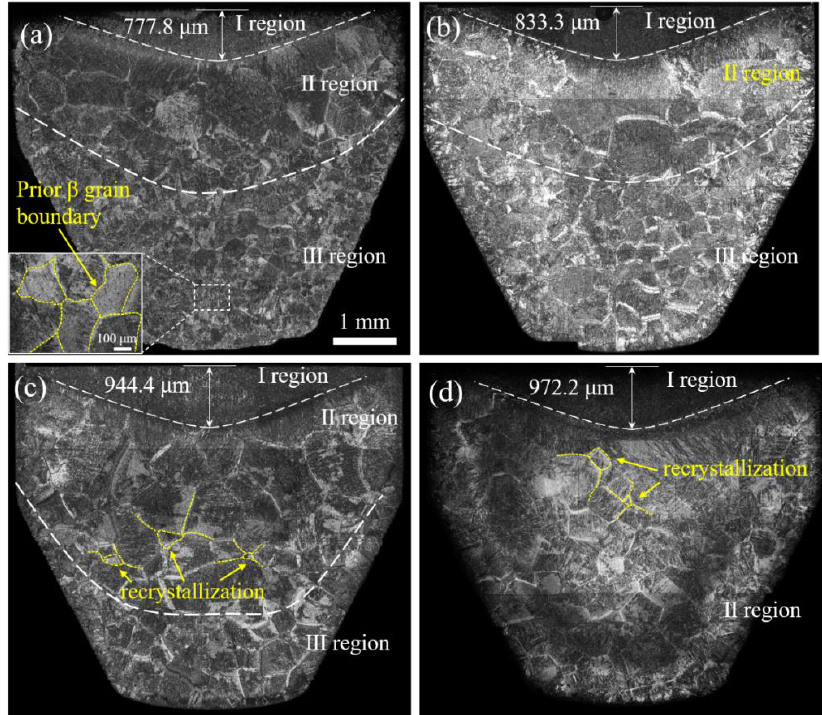
Figure 6. The billet microstructure at the end of each holding time. ( a ) 5 s; ( b ) 60 s; ( c ) 120 s; and ( d ) 180 s.